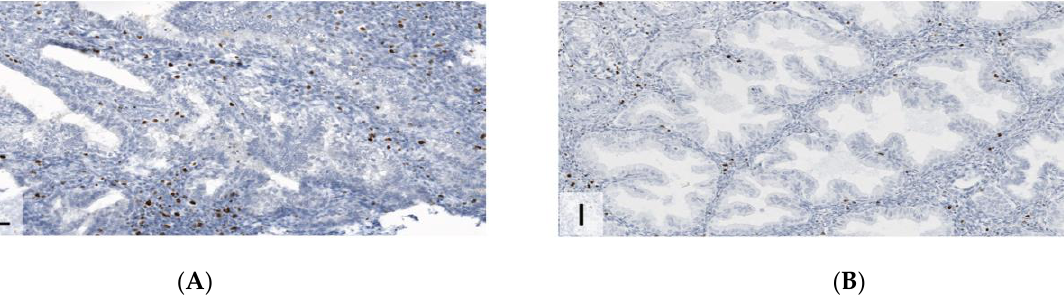
Figure 9. IHC for Ki67 (MiB1), demonstrating the same proliferative index (lower than in proliferative phase) in endometriosis compared to endometrium (×200). ( A ) Endometriosis. ( B ) Endome- trium.